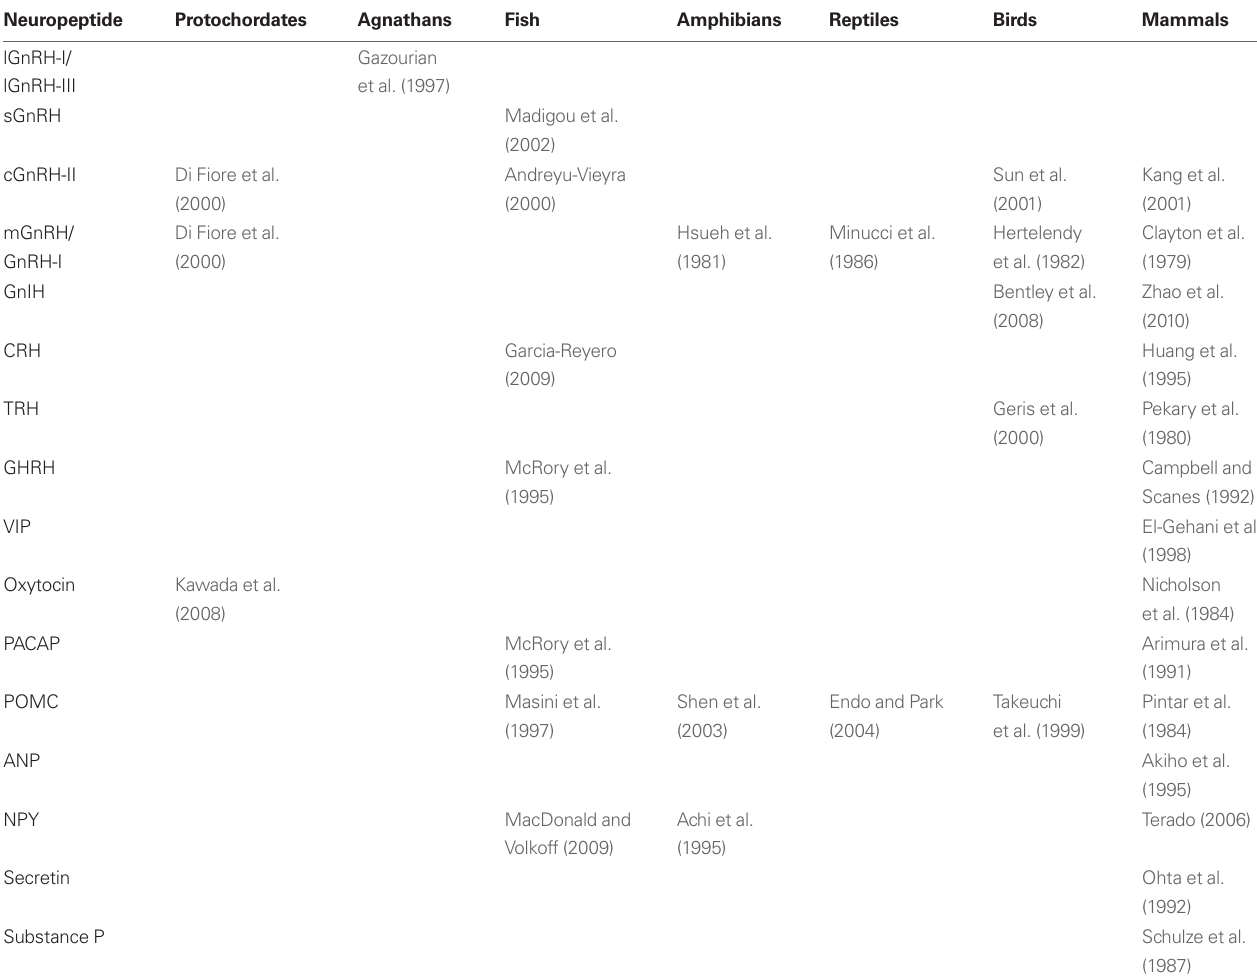
Table 1 | Presence of neuropeptides in the gonads of vertebrates. GnRH isoforms appear to be highly conserved across vertebrates, but there are large gaps in our knowledge of the evolution of other gonadal